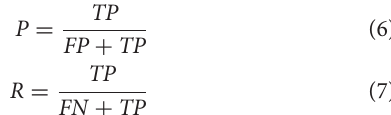
the two groups have the same smooth L1 loss value and a quite different